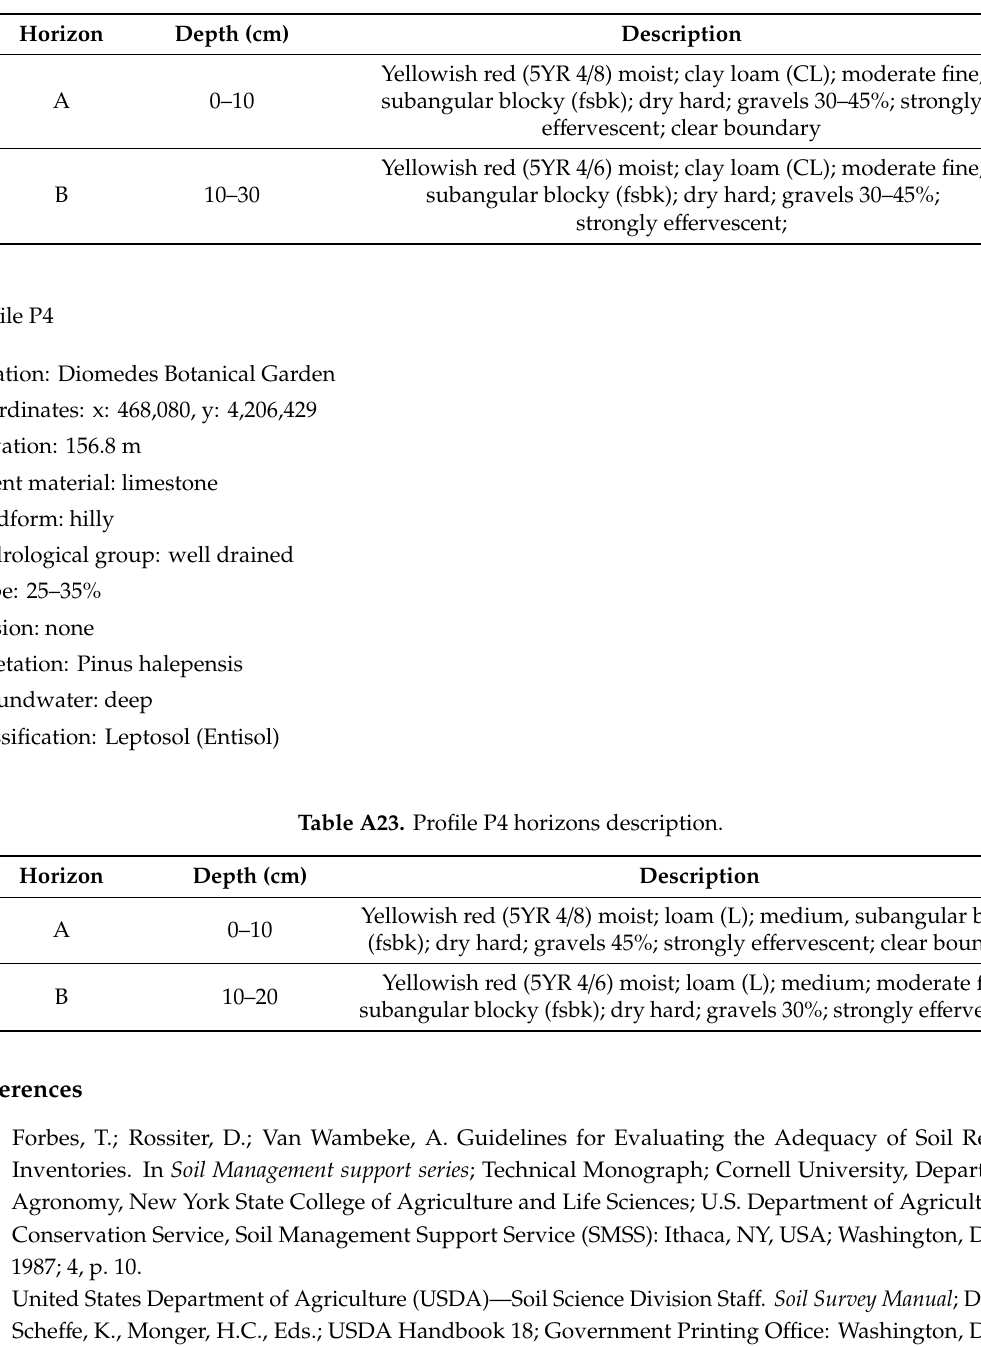
Table A22. Profile P3 horizons description.